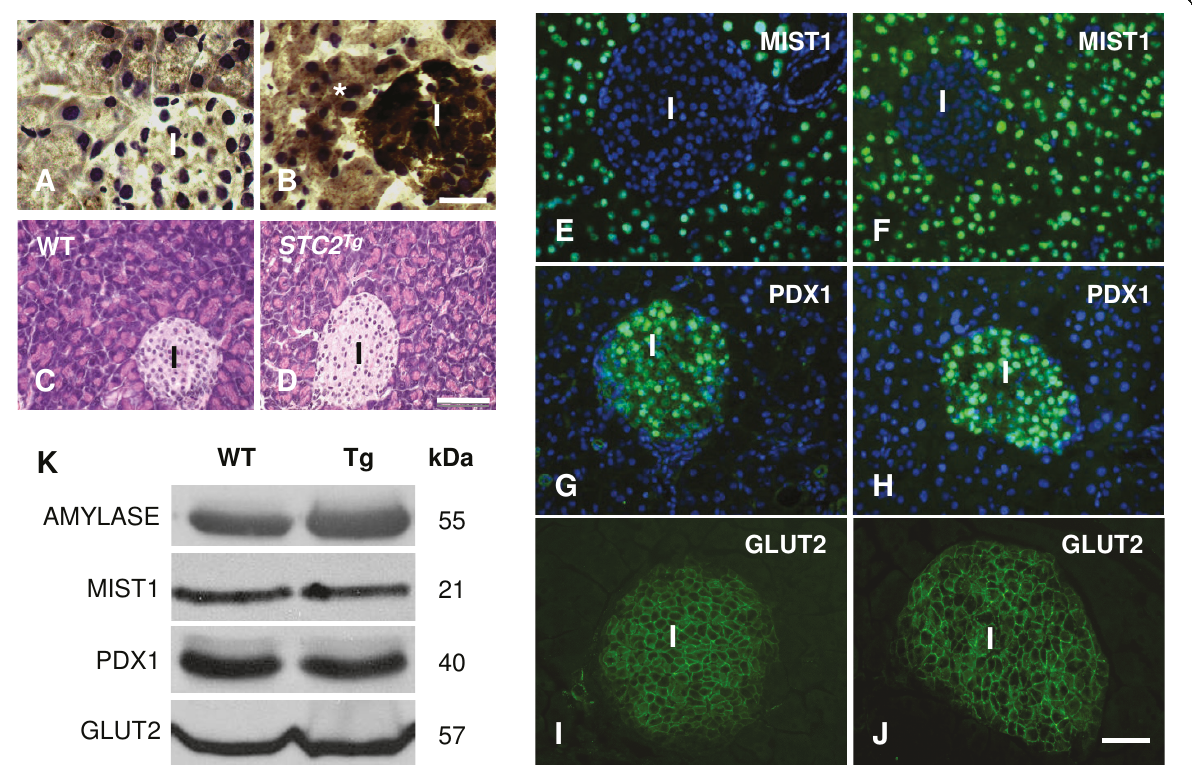
Figure 2 Overall morphology and differentiation does not appear to be affected in STC2 Tg mice . (A, B) IHC for STC2 in WT ( A ) and STC2 Tg ( B ) pancreatic islets shows that STC2 accumulates in both acinar (*) and islet (I) tissue only in the STC2 Tg mice. Magnification bar = 27 μ m. Tissue was counterstained with hematoxylin to reveal tissue morphology. (C, D) Hematoxylin and eosin staining comparing general histology of pancreatic tissue in WT (C) or STC2 Tg (D) pancreata. Magnification bar = 60 μ M; I - islet. IF analysis for MIST1 (E, F) , PDX1 ( G, H ) or GLUT2 ( I, J ) in WT ( E, G, I ) or STC2 Tg ( F, H, J ) pancreata. Magnification bar = 54 μ m. (K) Representative Western blot analysis for pancreatic differentiation markers amylase, MIST1, PDX1 and